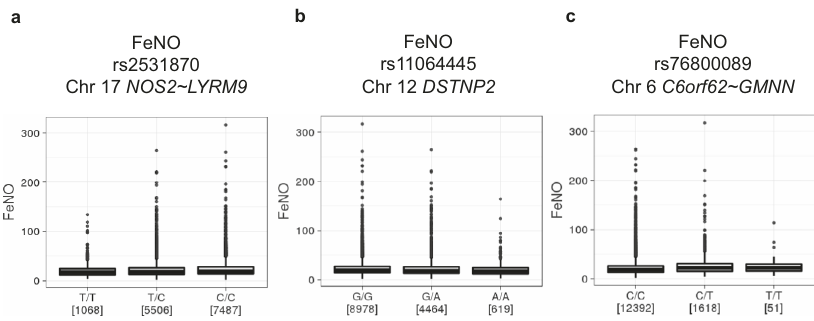
Fig. 8 The effects of genetic variants repeated at both Discovery and Validation Stage for FeNO. a – c The levels of FeNO in each genotype of the sentinel variant are shown. Format of the boxplots is the same as in Fig. 4. FeNO exhaled nitric